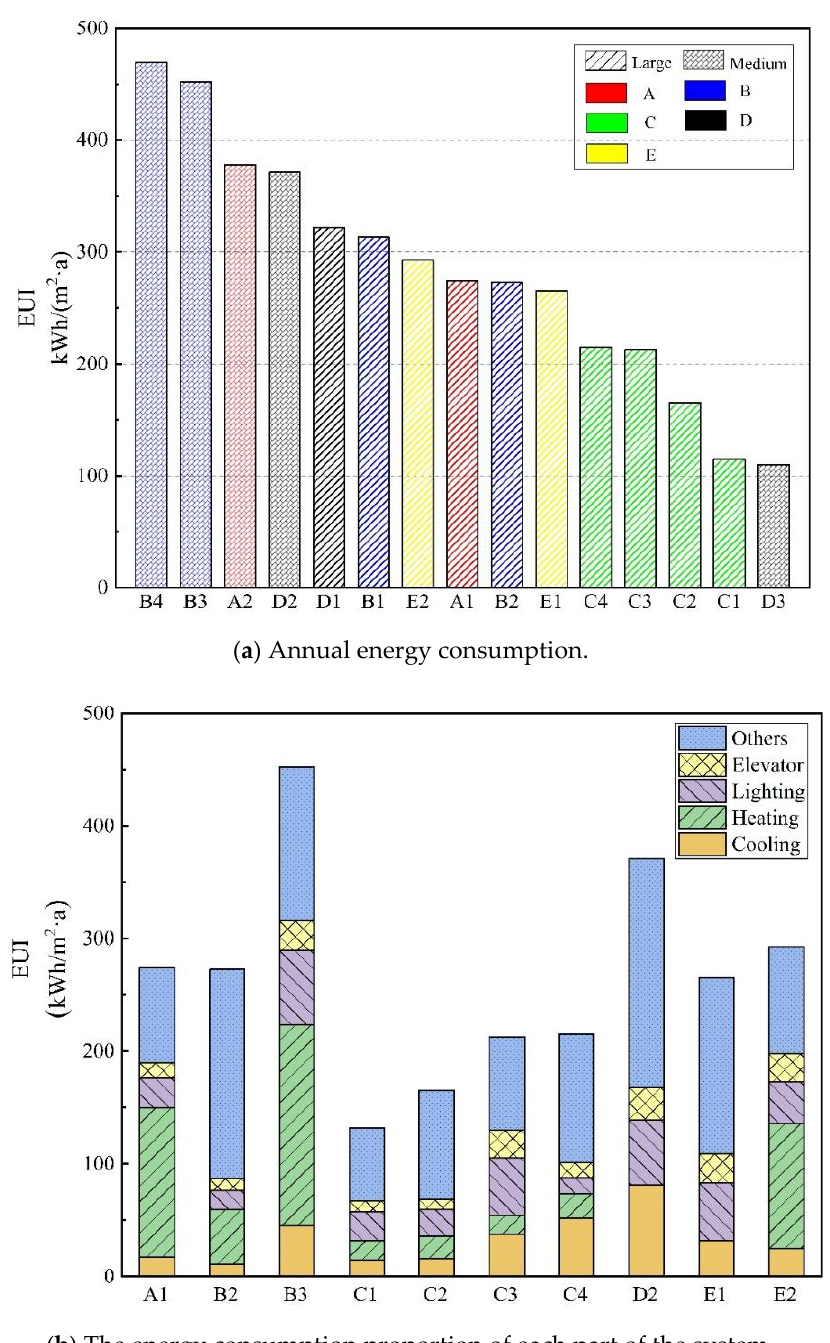
Figure 3. Statistical results of energy consumption of high-speed railway stations. Table 2. Energy consumption data of different buildings.